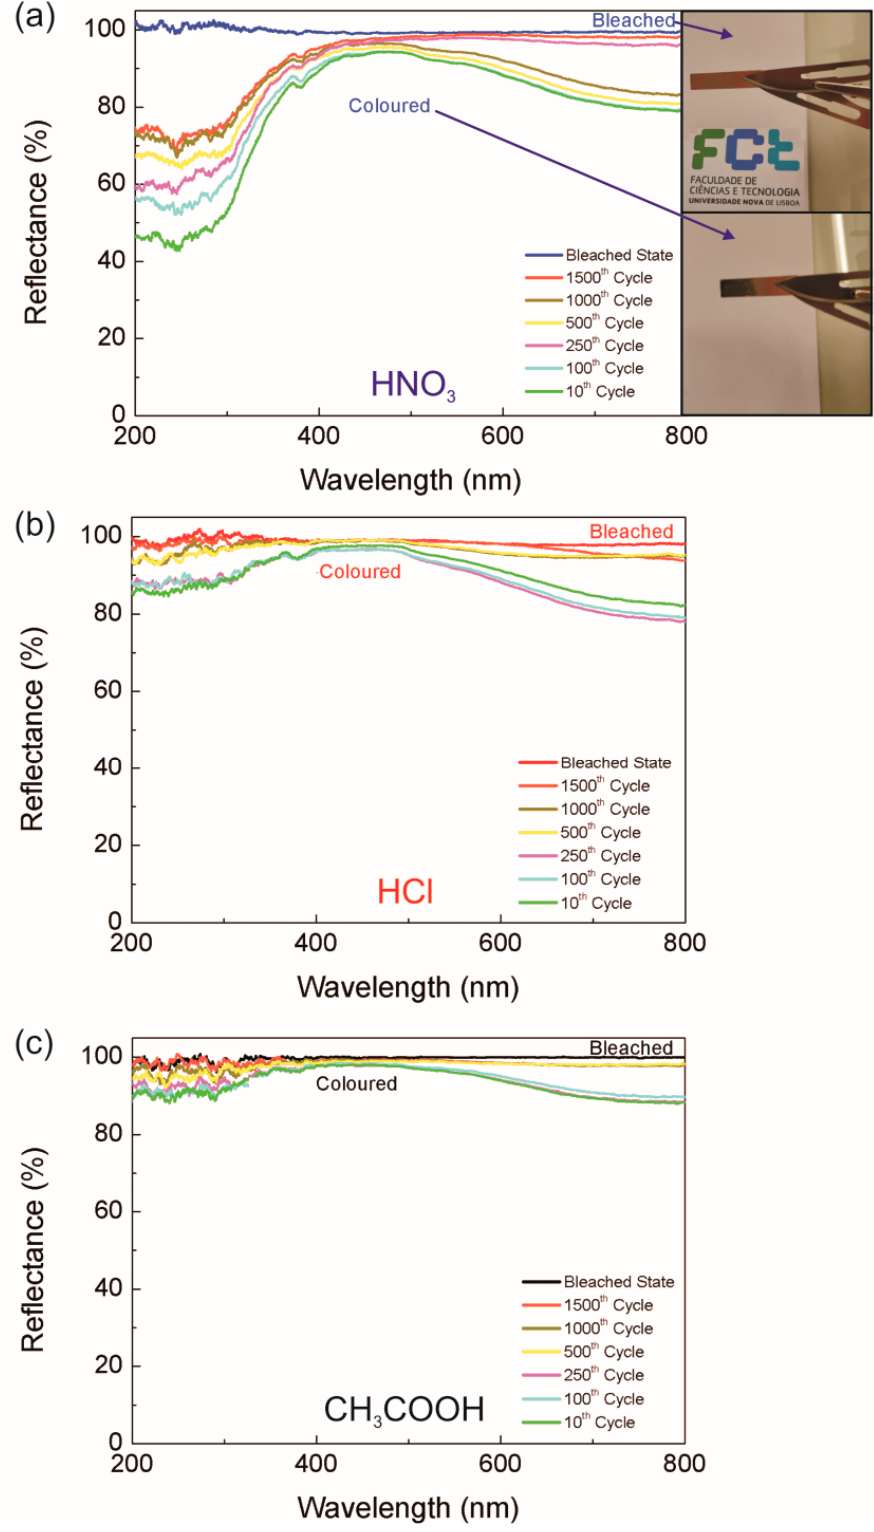
Figure 5. Reflectance spectra of the TiO 2 nanostructured films for colored and bleached states obtained after 10, 100, 250, 500, 1000 and 1500 coloration/bleaching cycles, applying ±5 V. The bleached spectra presented was measured after 250 cycles. The results for TiO 2 nanostructured films synthesized using nitric acid are presented in ( a ), hydrochloric acid in ( b ), and acetic acid in ( c ). It also presented an image of the nitric-based TiO 2 film on the colored and bleached states carried out at room temperature.